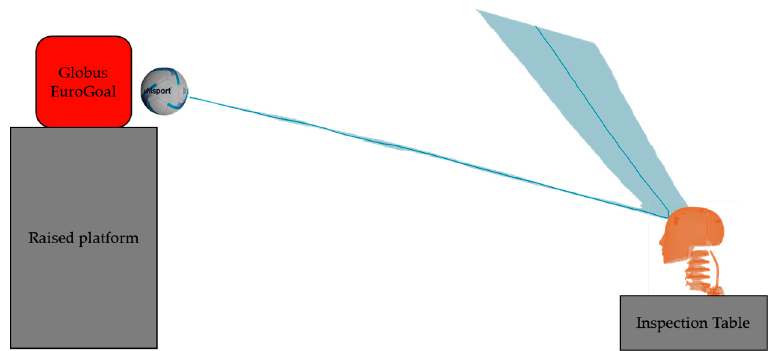
Figure 2. Experimental setup of EuroGoal, headform, and example impact